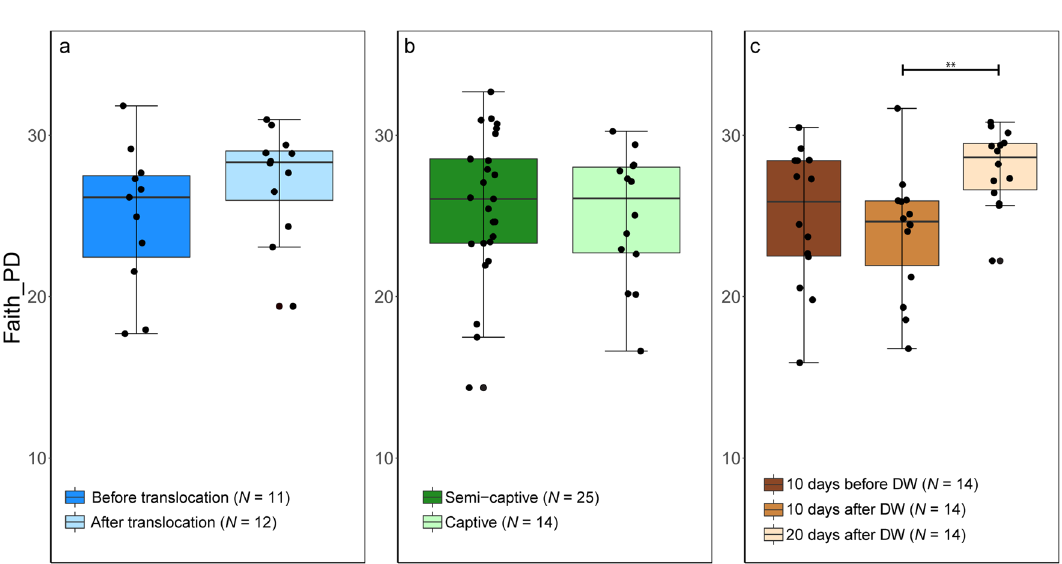
Figure 3. Box and whisker plot describing the alpha diversity comparisons between microbiome communities in Asian elephants. Faith’s Phylogenetic Diversity was used to measure the microbiome diversity and phylogenetic relationships between the features associated with elephants before (BT) and after (AT) translocation (a) , in captivity and semi-captivity (b) and 10 days before, 10 days after and 20 days after deworming (c) . ** p < 0.01 (Wilcoxon-signed rank